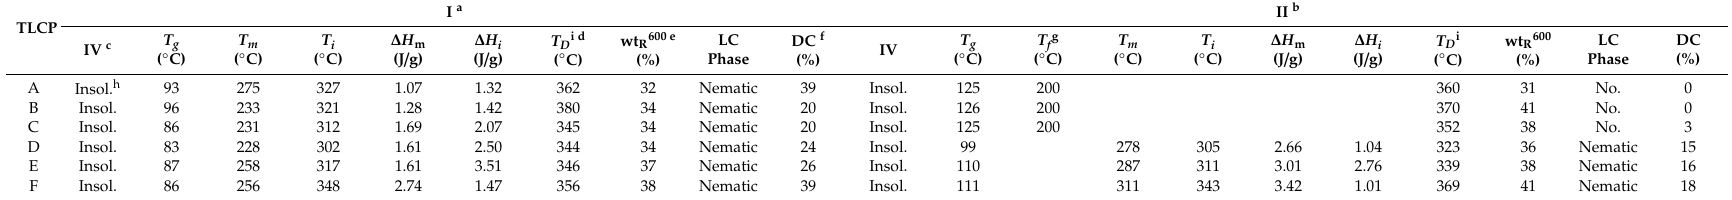
Table 3. General properties of